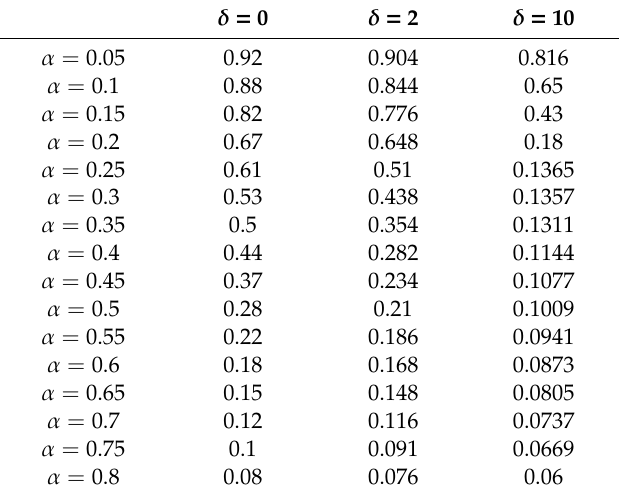
Figure 6. Invulnerability analysis of the traditional attack strategy under di ff erent values of the attack accuracy. Table 4. Statistical table of the traditional attack strategy data under di ff erent values of the attack